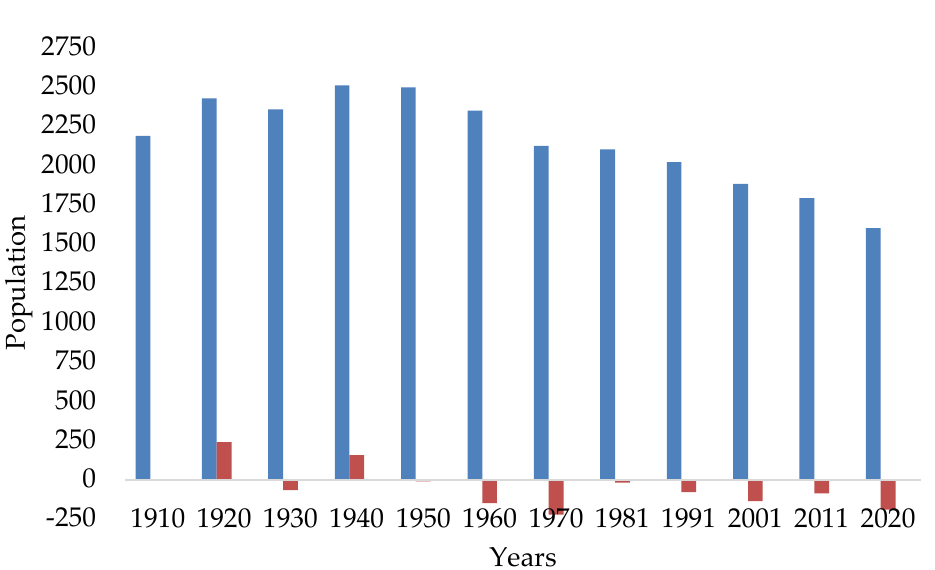
Figure 2. Total population (blue bars) and variation in total population in the given period (red bars) in Cuevas del Becerro (1910–2020).